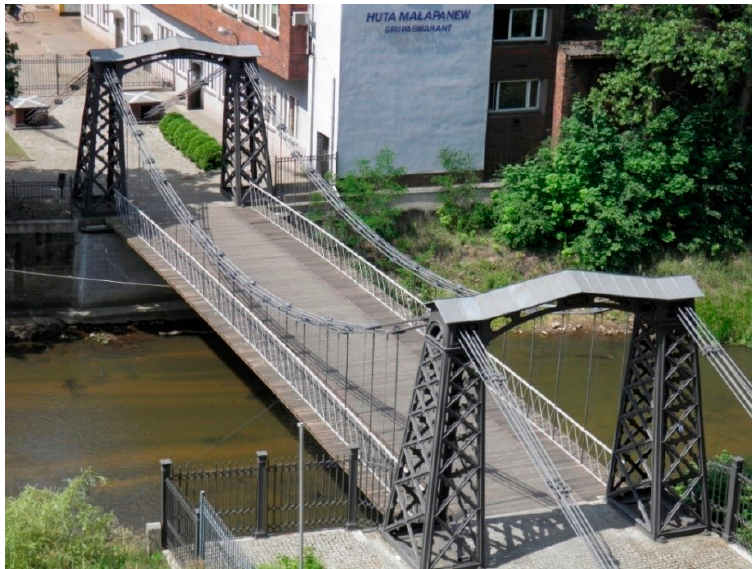
Figure 1. Top-view of the examined historical cast-iron suspension bridge.